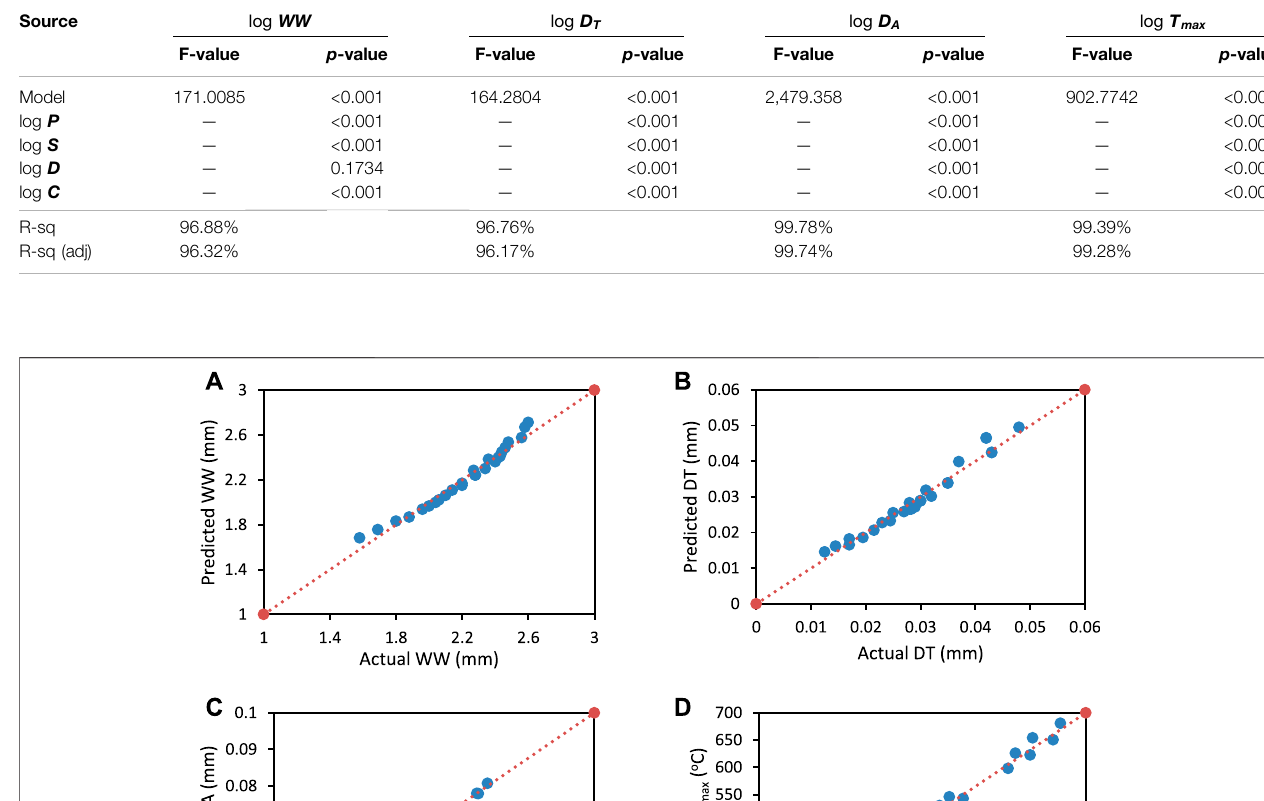
Frontiers in Materials |